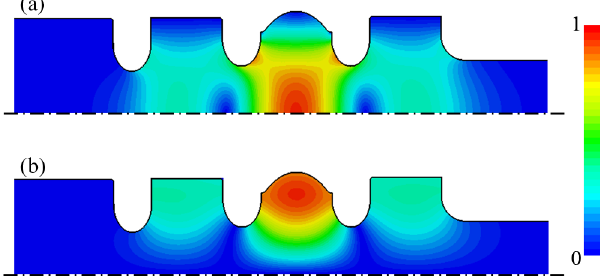
FIG. 3. The π -mode (a) electric and (b) magnetic field dis- tribution of the structure with axisymmetric elliptical central cell sidewall. For a gradient of 100 MV = m, structure surface peak electric and magnetic fields are 186 MV = m and 441 kA = m, and the required input power is 2.1 MW.